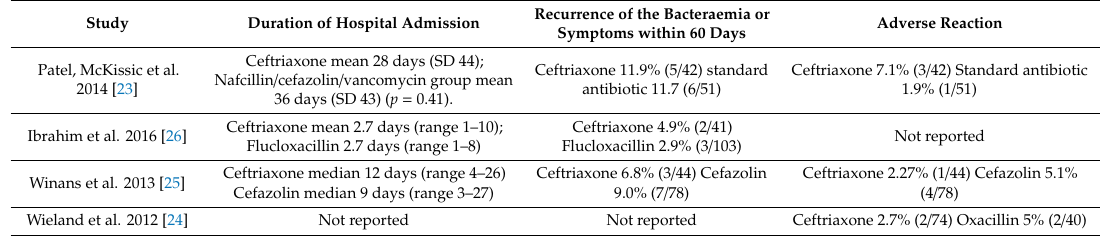
Table 5. Outcomes (cohort